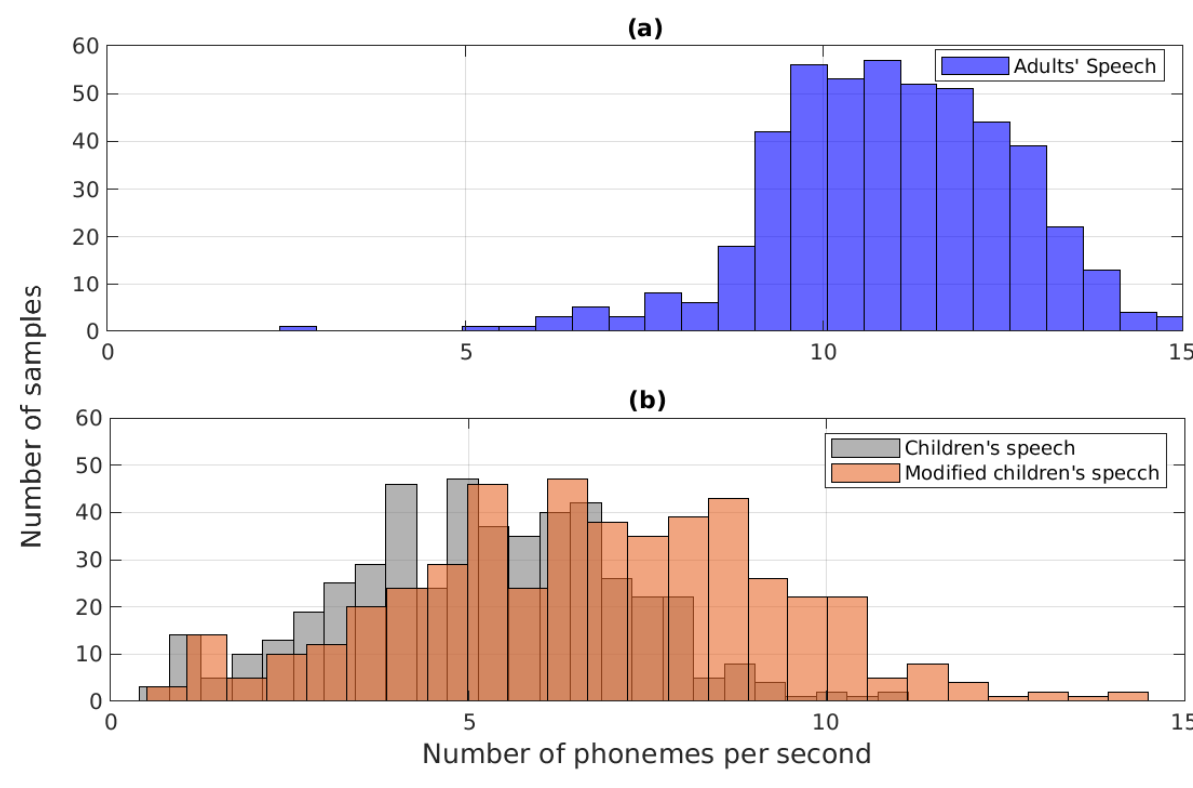
Figure 5. Number of phonemes per second as histograms for ( a ) adults’ speech, ( b ) children’s speech and modified children’s speech processed by the speaking rate modification